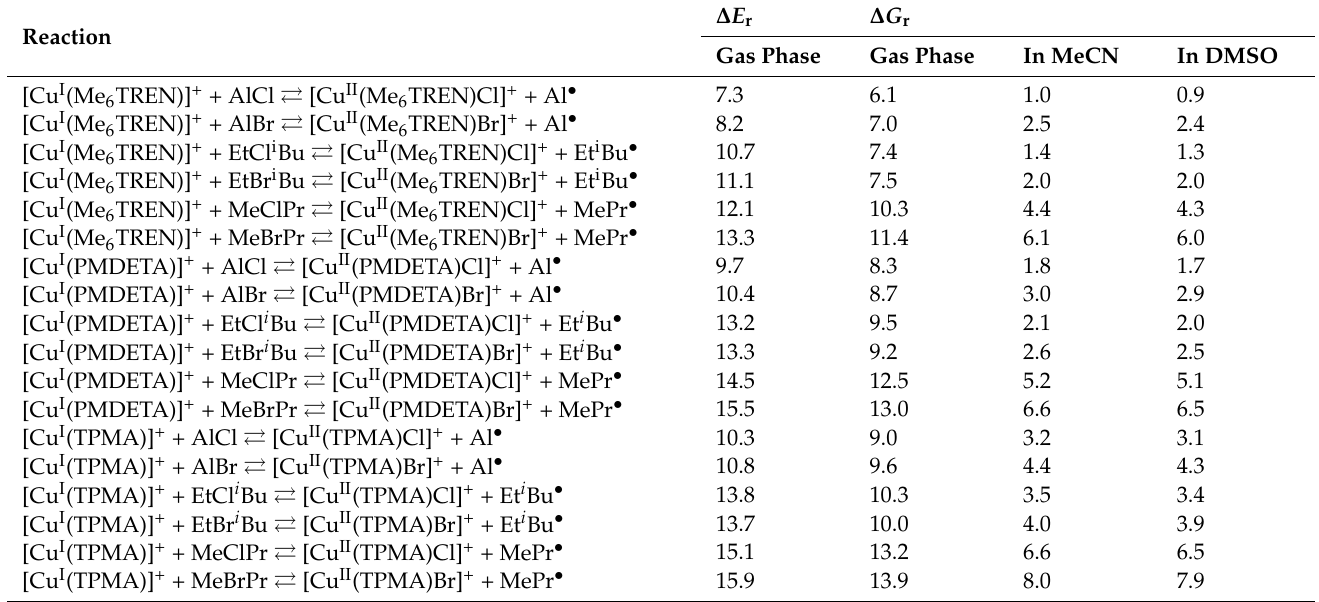
Table 2. ∆ E r and ∆ G r (kcal/mol) of reaction (1) calculated in gas phase and in solution; level of theory: